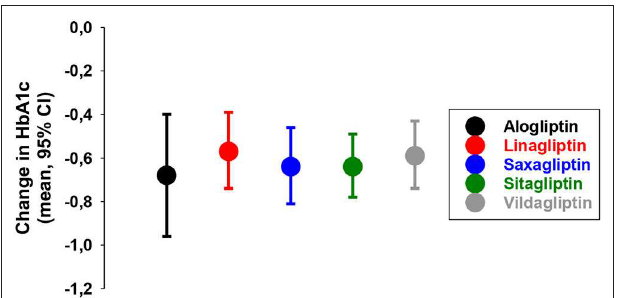
FIGURE 8 | Placebo-adjusted change in HbA1c from 83 randomized clinical trials when a DPP-4 inhibitor was added to on-going therapy with metformin in subjects with type 2 diabetes as reported in a meta-analysis